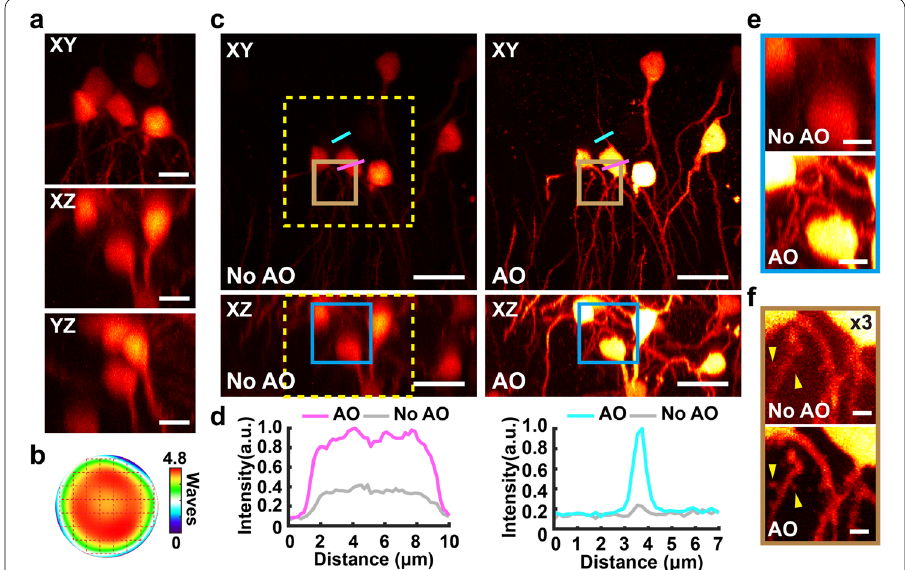
Fig. 3 AO enables high-resolution imaging in brain tissue sections. a Maximum intensity projection of the neuronal structures with which the aberration was measured. The structures are centered 250 μm below the tissue surface. b Corrective wavefront. The dashed squares indicate the layout of the wavefront segments, where each wavefront segment corresponds to a unit square. An independent mask approach was used in the measurement process. c Maximum intensity projection of the neuronal structures 240–260 μm (XY) and 230–270 μm (XZ) below the tissue surface. The dashed yellow boxes indicate the positions of the structures in ( a ). d Intensity profiles along the magenta and cyan lines in ( c ). e, f Zoomed-in views of the blue and brown boxes in ( c ) . The image without AO correction in the brown box is enhanced with a 3x digital gain to increase the visibility. The yellow arrowheads in ( f ) indicate the spines. Scale bars, 10 μm in ( a ), 20 μm in ( c ), 5 μm in ( e ) and 2 μm in ( f